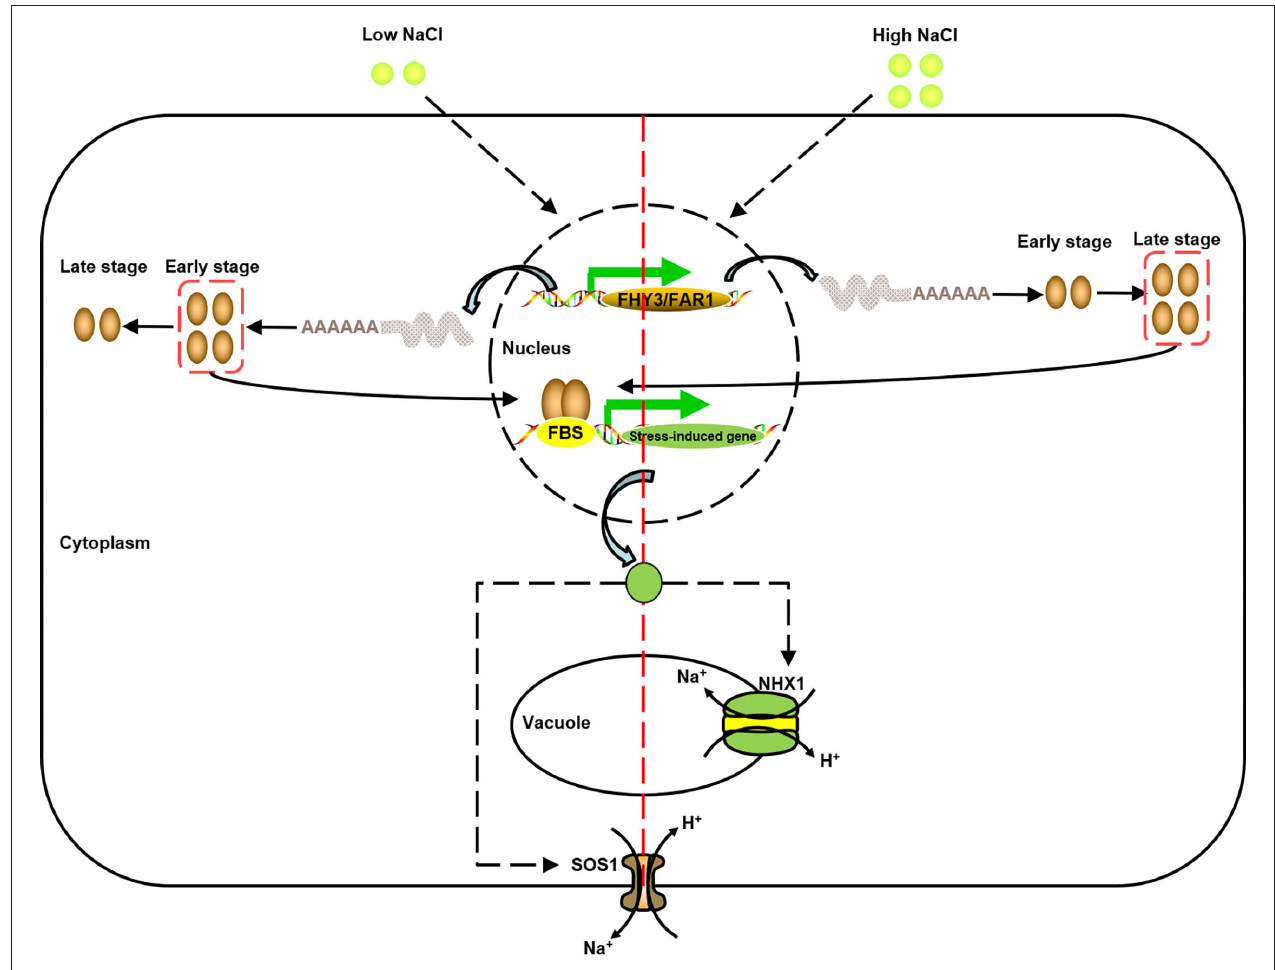
FIGURE 9 | A model of the function of FAR1/FHY3 under salt stress (modified from Halfter et al., 2000; Shi et al., 2002; Zhou et al., 2018). Under high/low salt stress, due to different response activities, different FAR1/FHY3 genes were activated successively to further activate downstream salt stress-induced genes, and then achieved Na + balance inside and outside the vacuole and cell membrane through SOS